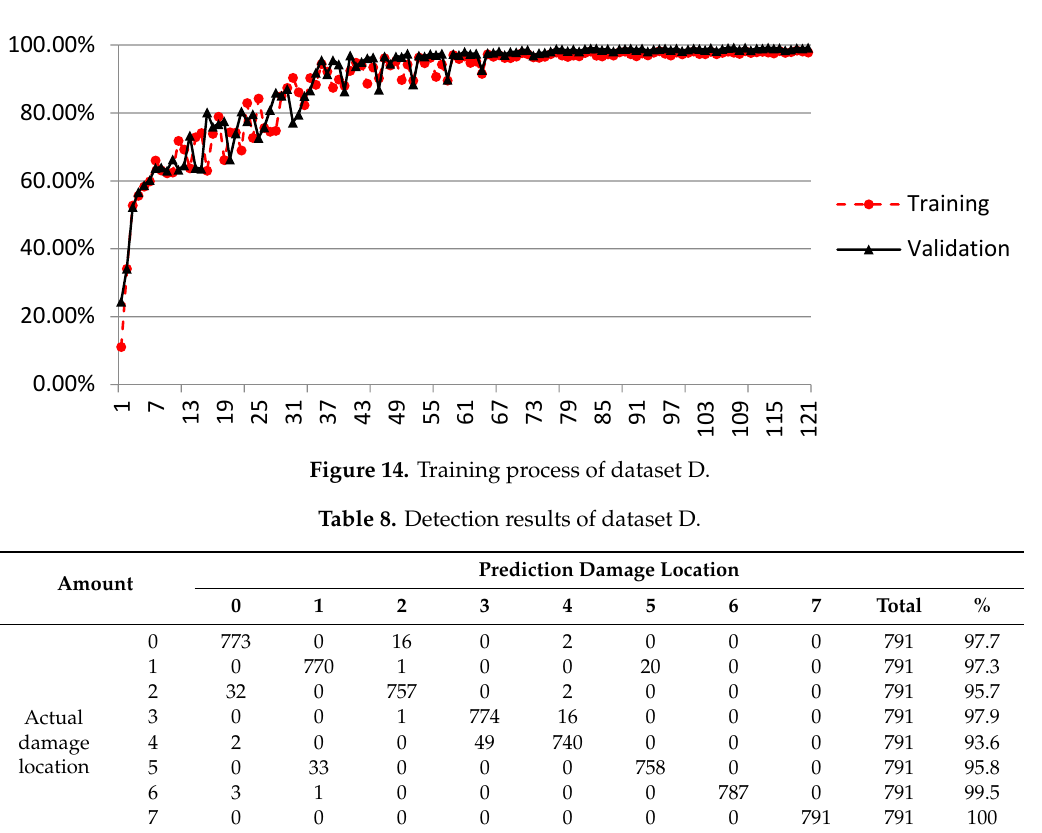
Figure 15. Acceleration time-history curve.